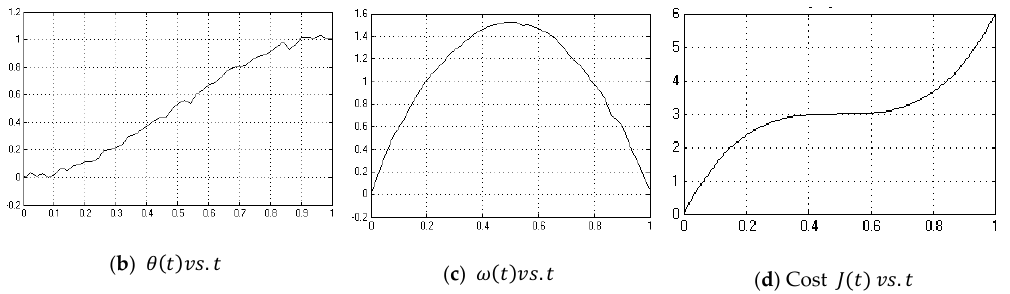
Figure A2. Optimum open loop controller simulation model with noise and results.